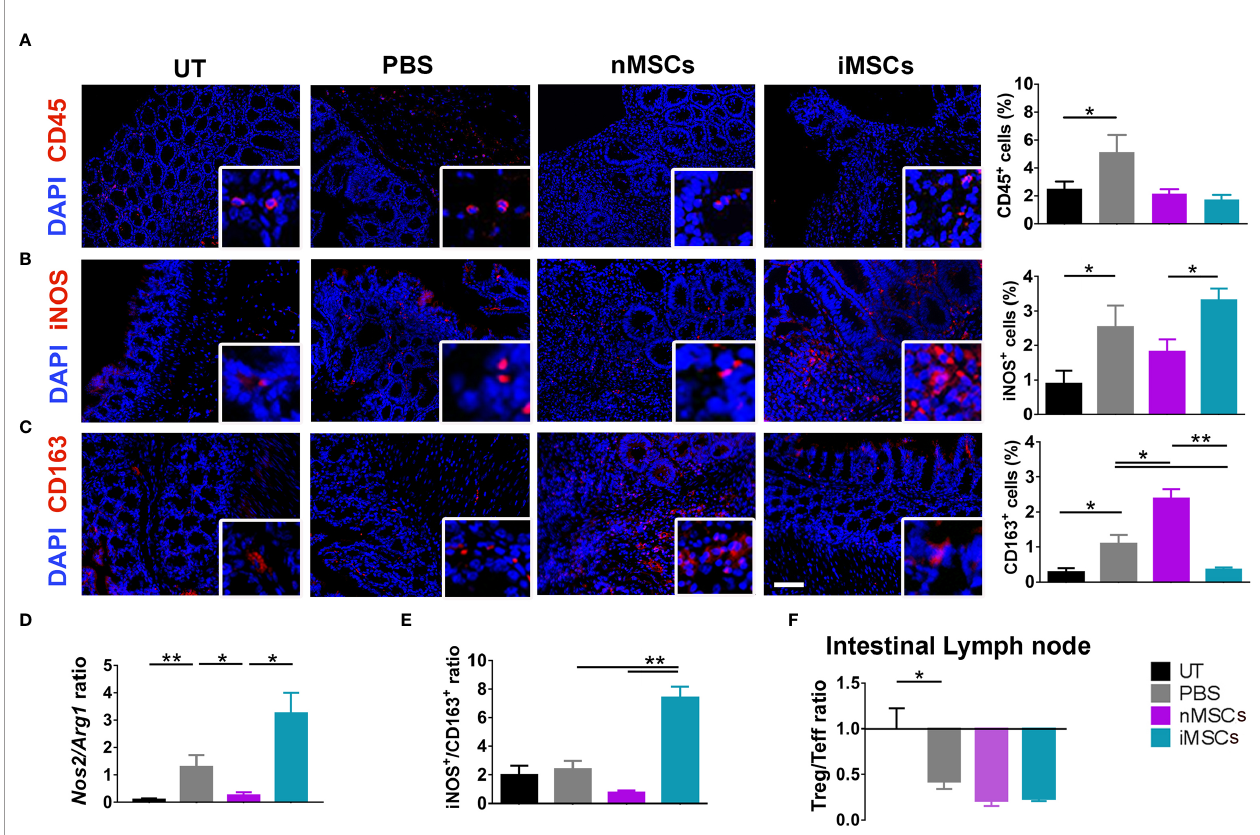
FIGURE 4 | Administration of cytokine-conditioned MSCs is associated with pro-in fl ammatory polarization of intestinal macrophages. (A) CD45 pan lymphocyte IF. CD45 positive cells are equally present in nMSCs and iMSCs treated mice. (B, C) Immuno fl uorescence labeling of macrophage polarization markers in colon mucosa: IF (left), quanti fi cation (right). iMSCs induce iNOS protein, M1 marker. (D) qRT-PCR M1/M2 ratio: iEVs administration results in a signi fi cant presence of anti- in fl ammatory Arg1 gene. (E) protein M1/M2 ratio. (F) Treg/Teff ratio in the intestinal lymph node. Scale bar: 50 m m. Results are mean ± standard error (n = 5). *P < 0.05, **P <